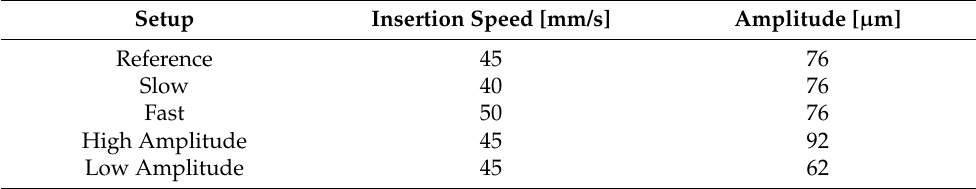
Table 1. Ultrasonic process setup for assessment of the connection quality. Setup Insertion Speed